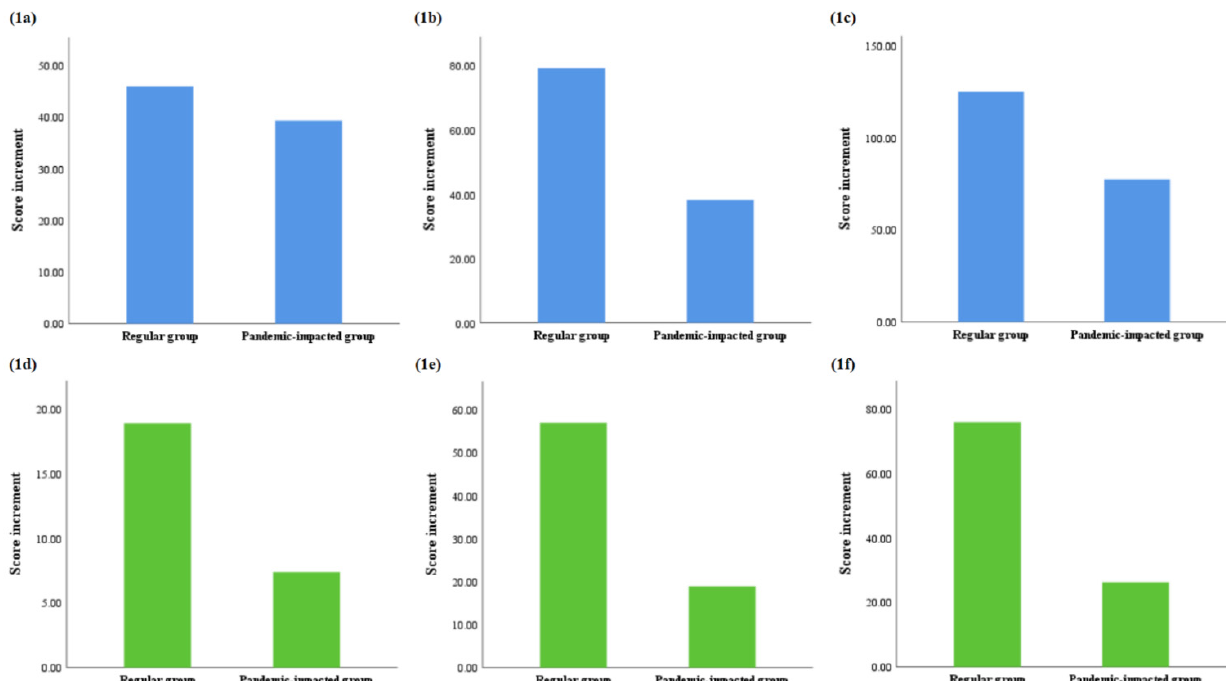
Figure 1. Total score increment of OSCE stations. ( 1a ) Total score increment between first mock OSCE and second mock OSCE, p = 0.715; ( 1b ) total score increment between second mock OSCE and national OSCE, p = 0.014; ( 1c ) total score increment between first mock OSCE and national OSCE, p = 0.003; ( 1d ) score increment of standardized patient-based stations between first mock OSCE and second mock OSCE, p = 0.404; ( 1e ) score increment of standardized patient-based stations between second mock OSCE and national OSCE, p = 0.003; ( 1f ) score increment of standardized patient-based stations between first mock OSCE and national OSCE, p < 0.001. Results were considered significant by p < 0.05.